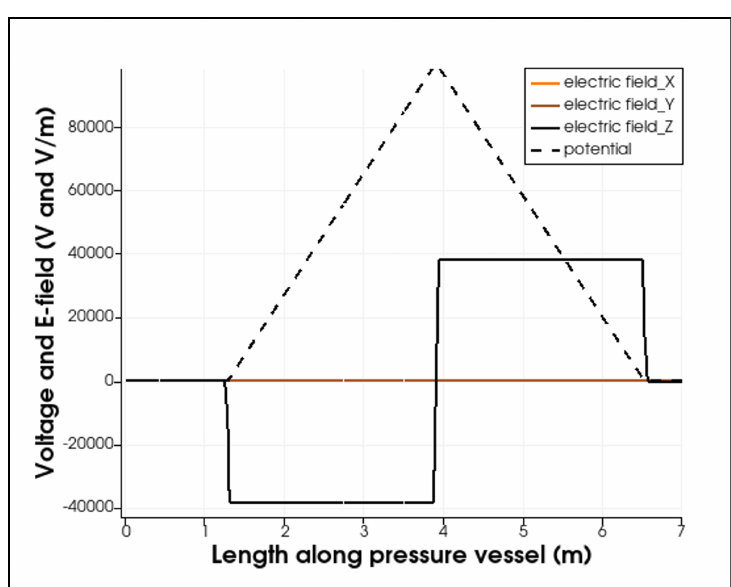
Figure A2. Voltage and field E z on the axis of the TPC.